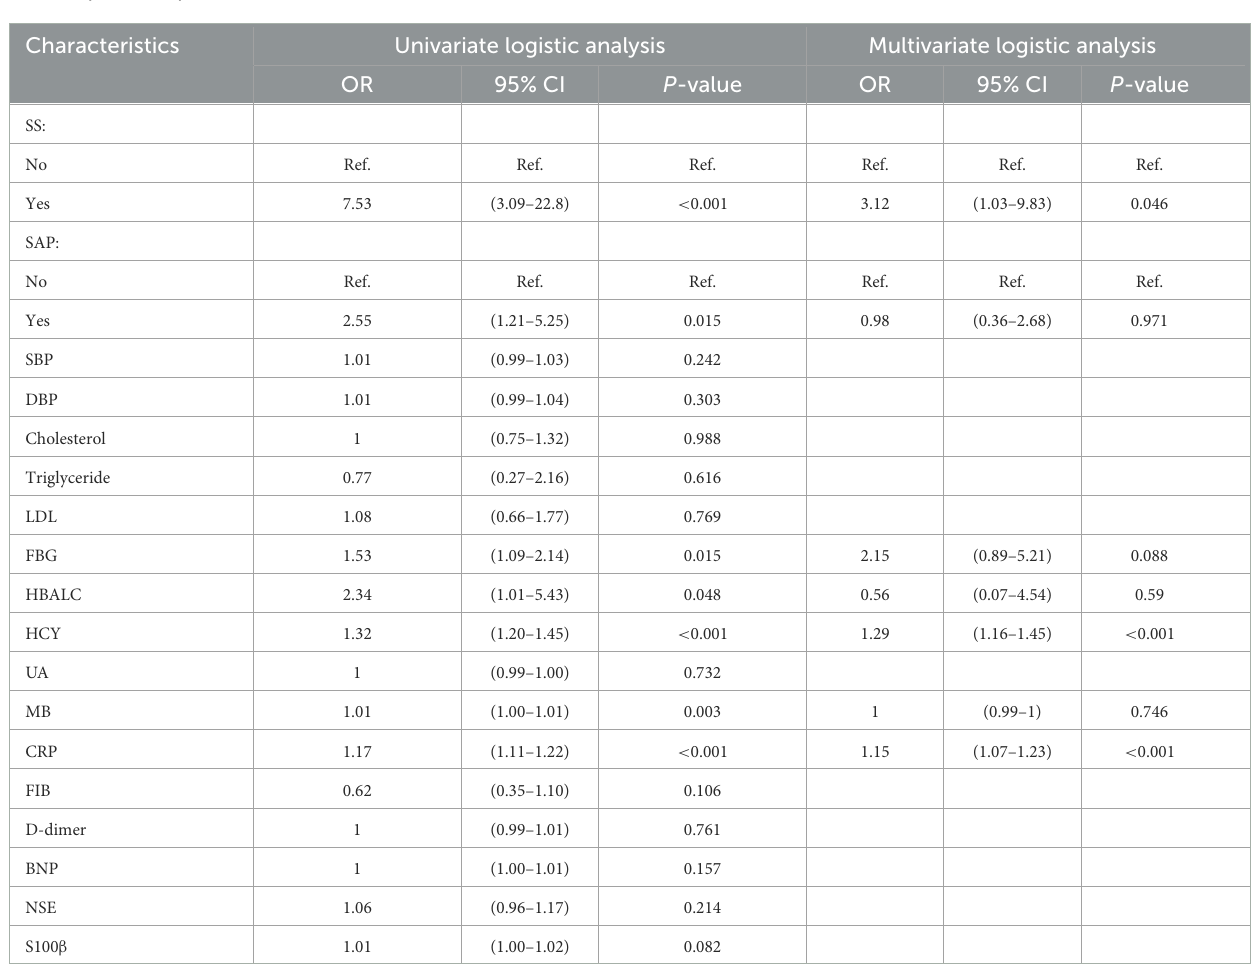
training group. The results are shown in Figure 1. Figure 2 shows the ROC curves of the predictive performance differences of the six ML algorithm models after external validation, and Figure 3 shows the result of radar plot analysis, which is a blanket,